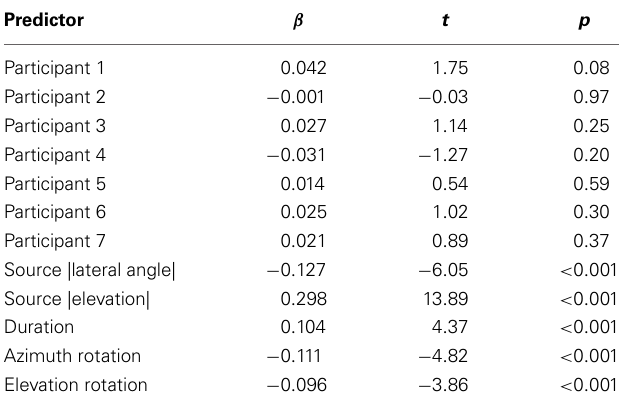
Table 2 | Results of multiple regression predicting elevation errors for trials where a front/back confusion was not made.